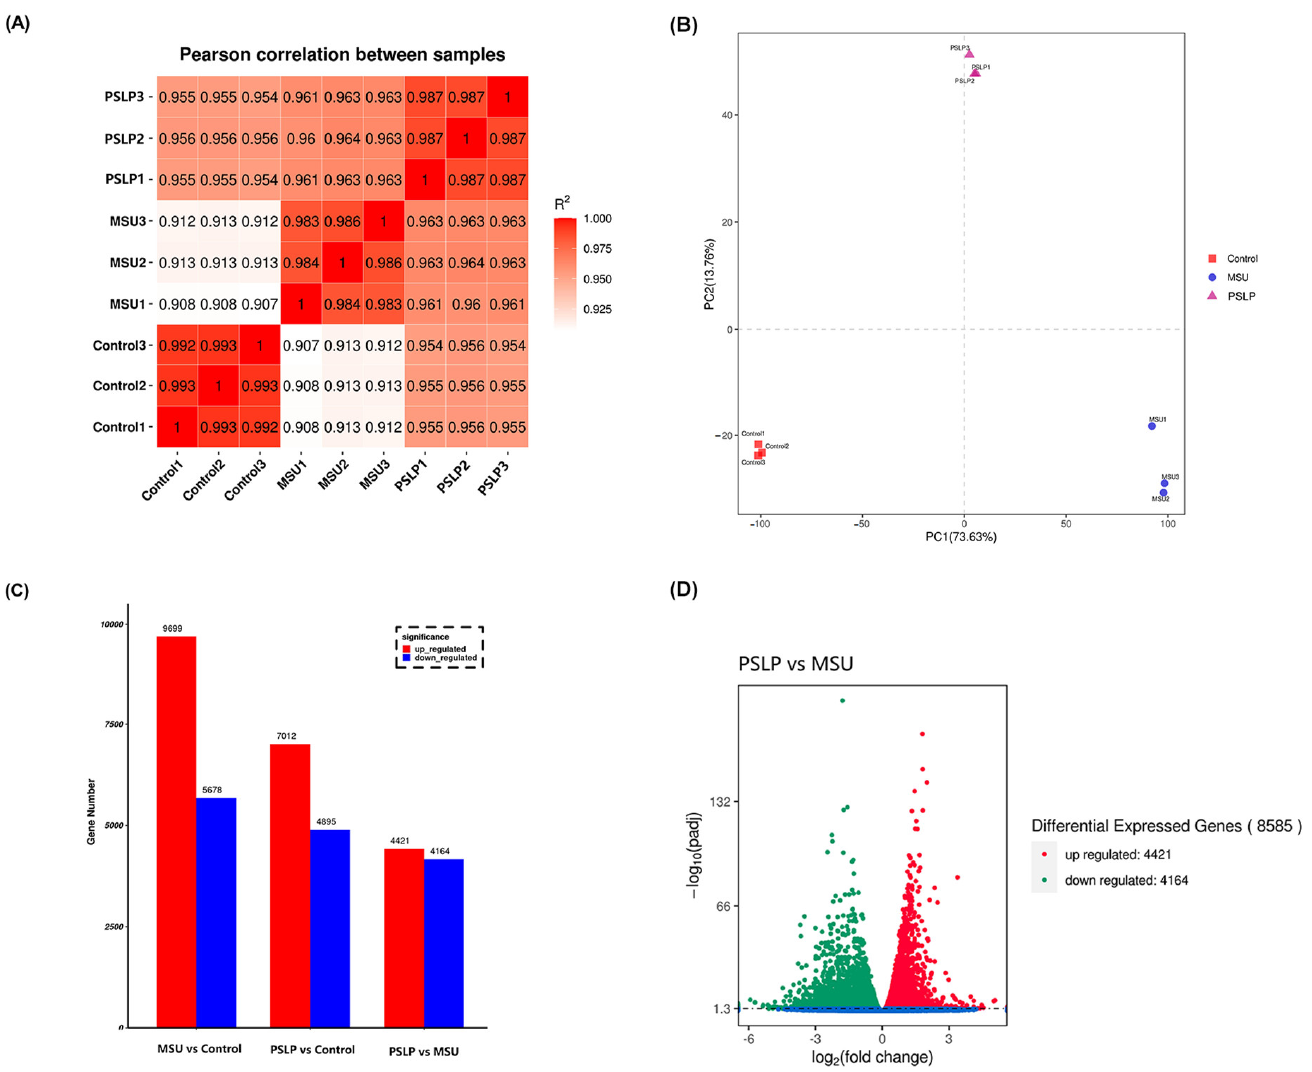
Figure 7. The changes in mRNA expression profiles in PSLP-treated RAW264.7 cells. ( A ) A sample correlation test. The darker red color represents the stronger correlation between groups. ( B ) PCA analysis of the whole transcriptomes of macrophages in the MSU group, PSLP group, and Control group. Different colors in the graph represent different groups. ( C ) Statistics of DEGs from the comparison of different treatment groups. ( D ) A volcano plot of DEGs between different treatment groups.